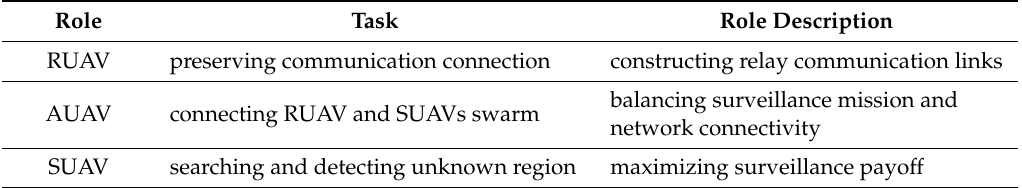
Table 1. Three UAV roles in cooperative surveillance with ground